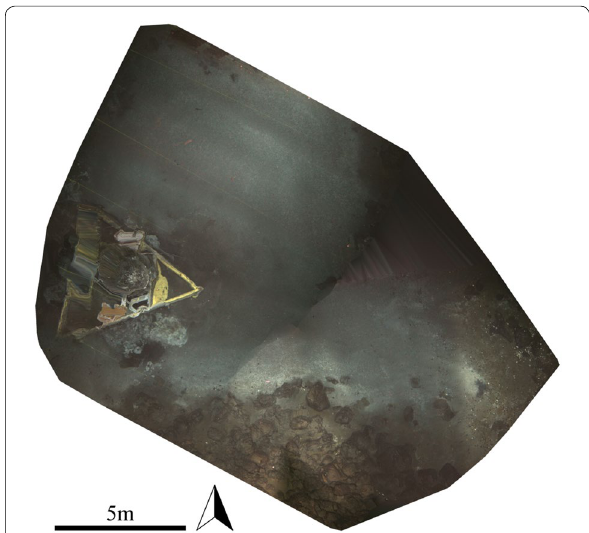
Fig. 8 Top view of a 3D colour reconstruction of the C0016B artificial hydrothermal vent and its surroundings